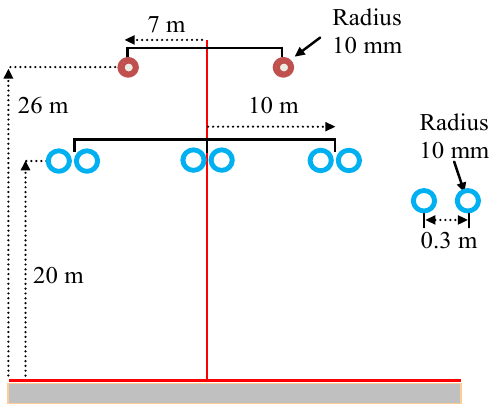
Figure 3: 275 kV Single circuit three phase overhead transmission line conductor.